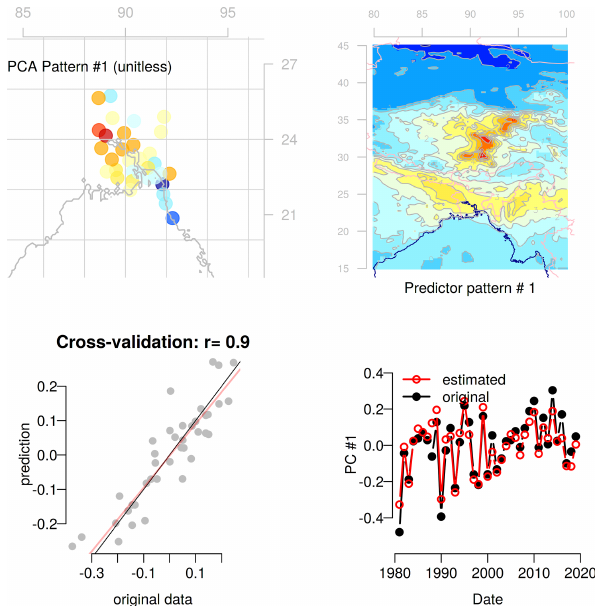
Figure 4. Evaluation of the statistical downscaling of the maximum temperature in the pre-monsoon season (March–May) for the lead- ing principal component of the predictand (PC1). The four panels show (a) the spatial pattern associated with PC1, (b) the predictor pattern associated with PC1, i.e., the spatial co-variance structure of the ERA5 reanalysis data used as predictor (the pre-monsoon sea- sonal mean temperature in the domain 80–100 ◦ E/15–45 ◦ N) and the leading principal component of the local temperature obser- vations in the calibration period 1981–2019, (c) a cross-validation comparing the original PC1 of the predictand and the corresponding estimated values obtained by empirical-statistical downscaling, and (d) time series of the estimated and original PC1 of the